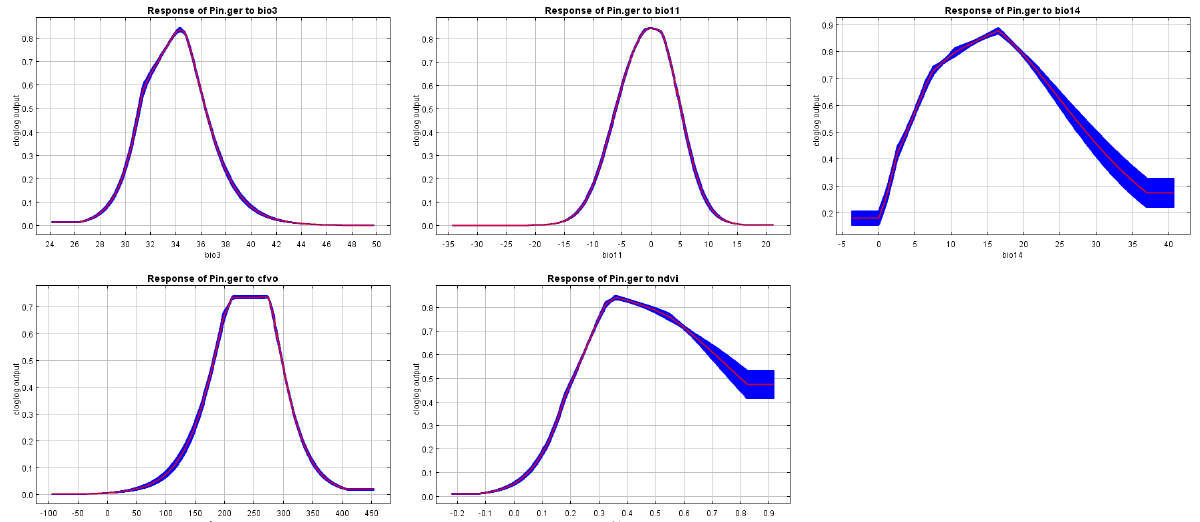
Figure 5. MaxEnt model response curves of the six bioclimatic and topographic variables used in the predictive species distribution modeling of P. gerardiana in south